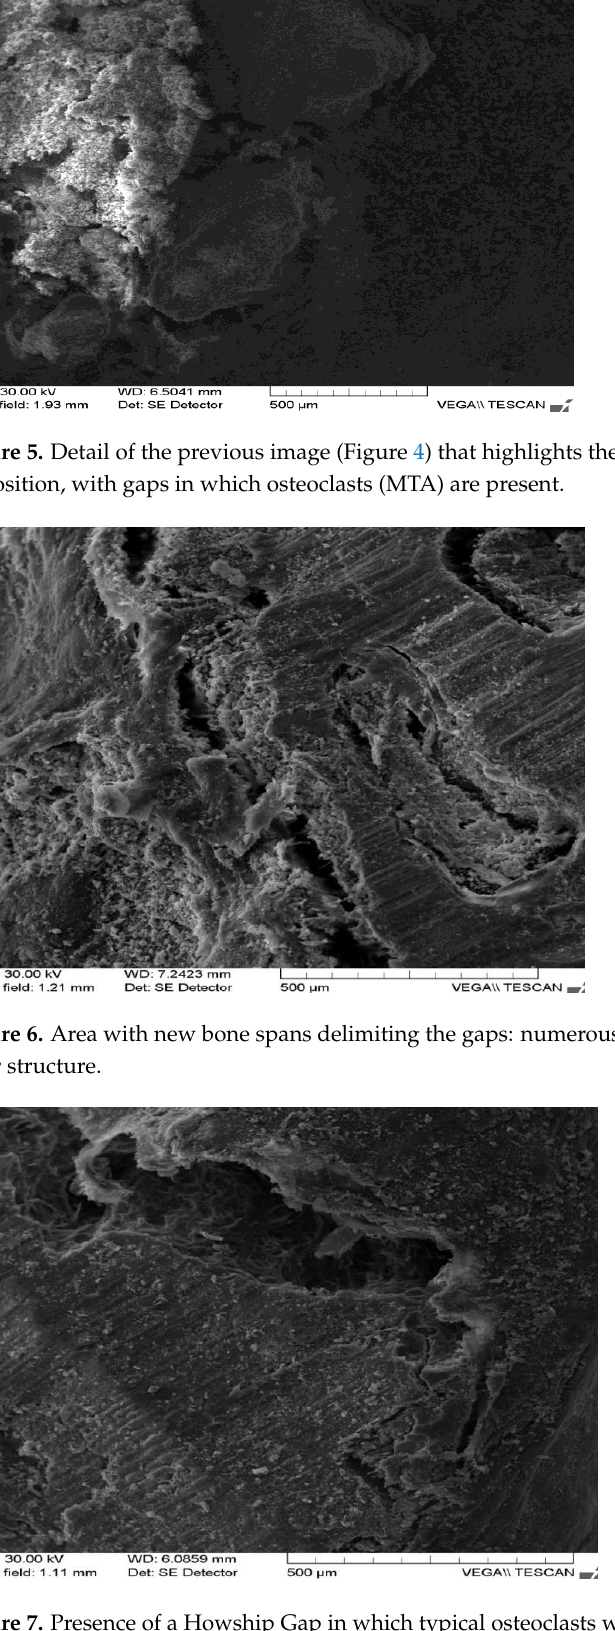
Figure 7. Presence of a Howship Gap in which typical osteoclasts with a brushed edge that attach to excess, newly formed dense material